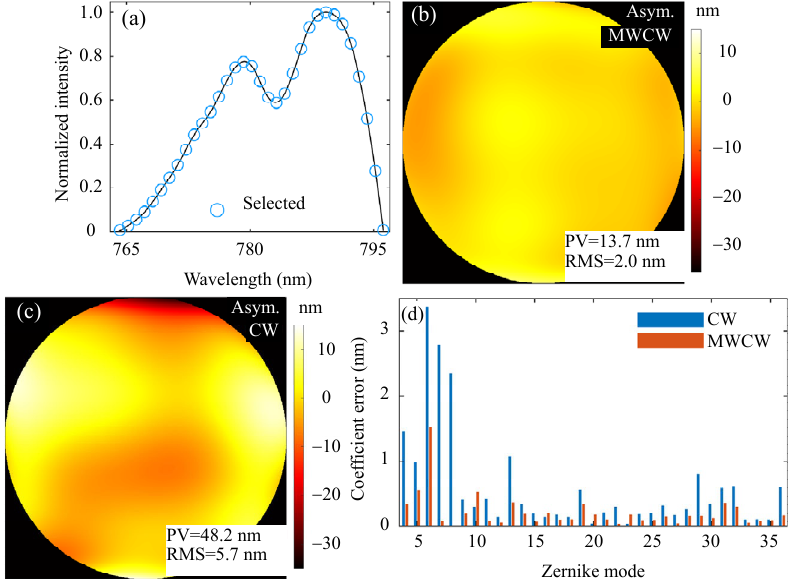
Fig. 4 Performance comparison of two methods when used for an asymmetrical spectrum S (  ): (a) S (  ) and selected  , wavefront errors obtained with (b) MWCW and (c) CW methods, and (d) absolute values of Zernike coefficient